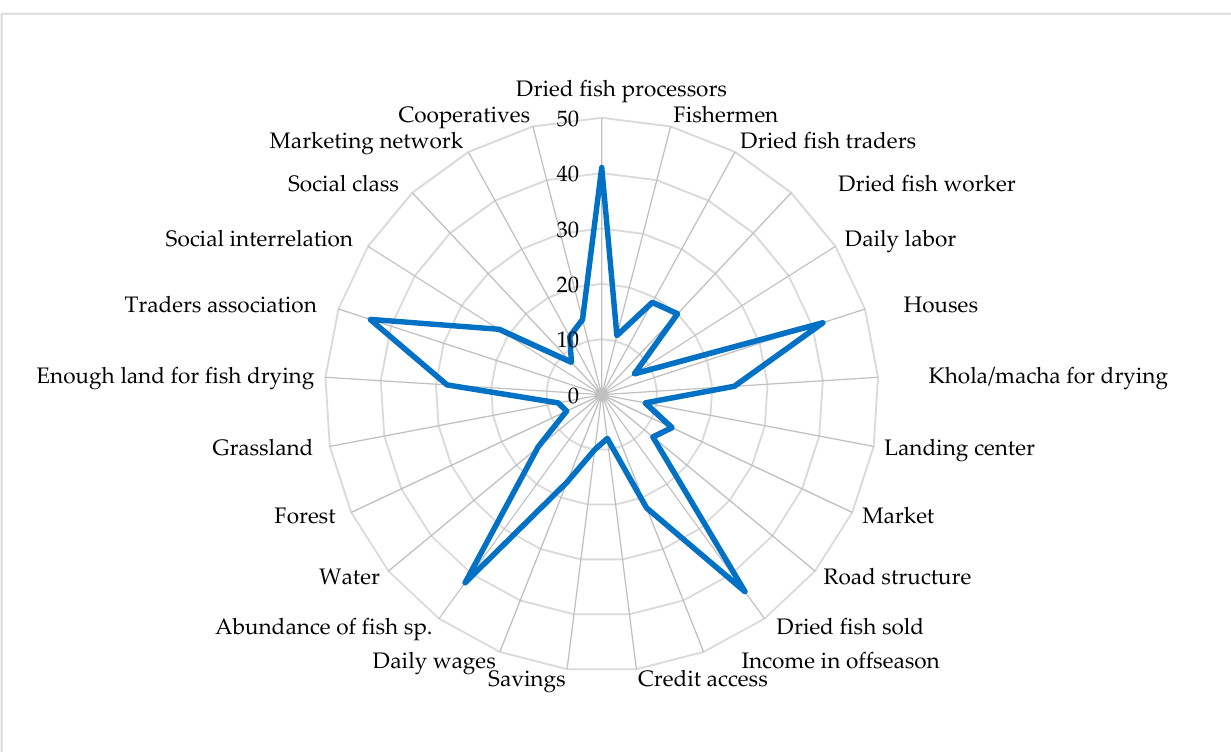
Figure 12. The relative importance (%) of livelihood assets in determining the community’s resilience. 3.11. Likelihood Ratio Test between Different Pairs of the Categorical Variable except religion and alternative occupation, had a significant association (1%, 5%) with the